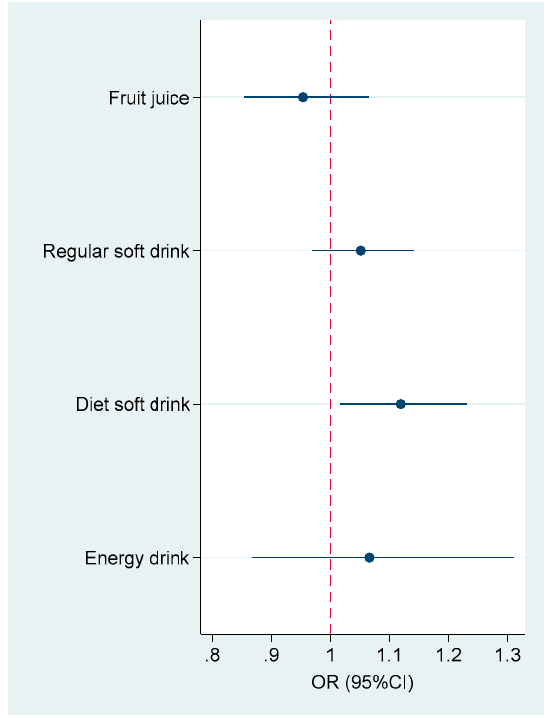
Figure 1. Association between different types of soft drink consumption and asthma. Model adjusted for age, gender, smoking, education, leisure time physical activity, intake of fruit and vegetable, and BMI (normal, overweight and obese). All the soft drinks were mutually adjusted. Soft drinks were used as continuous variables (times/week) in the logistic model.